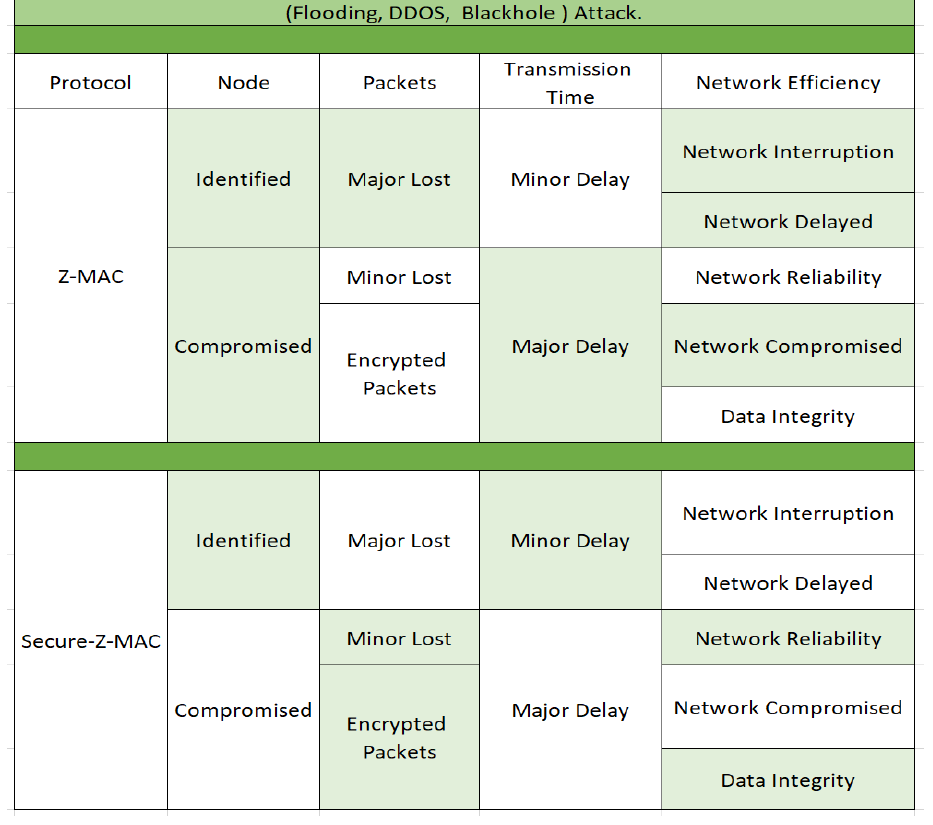
Figure 15. Comparison of Z-MAC and the secure Z-MAC protocol in terms of performance during the flooding attack, DDOS attack, and blackhole attack.